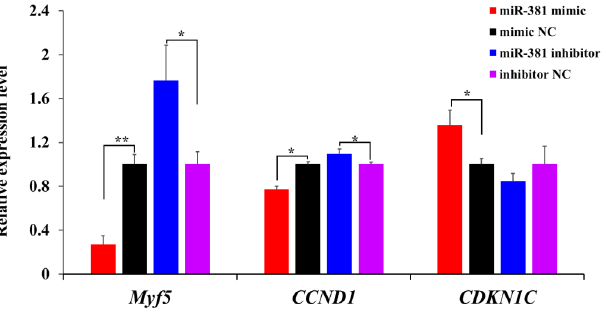
Figure 4. The effect of miR-381 on the expression levels of three proliferation marker genes Myf5 , CCND1 and CDKN1C in caprine SMSCs detected using RT-qPCR. * p < 0.05, ** p < 0.01.